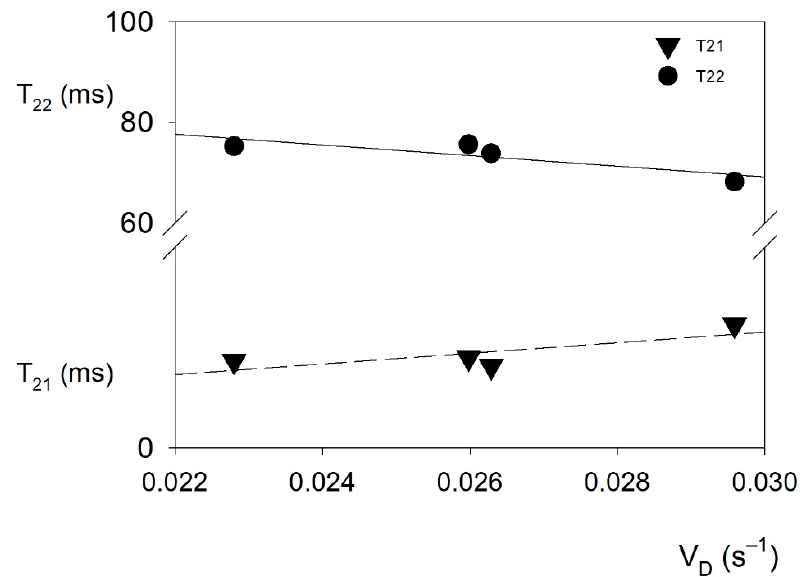
Figure 5. Linear correlation between transport rate (V D ) and short (T 21 ) and long components (T 22 ) of the spin–spin relaxation times. (Pearson r = − 0.849; p = 0.076 and r = 0.801; p = 0.100 for T 21 and T 22 , respectively).